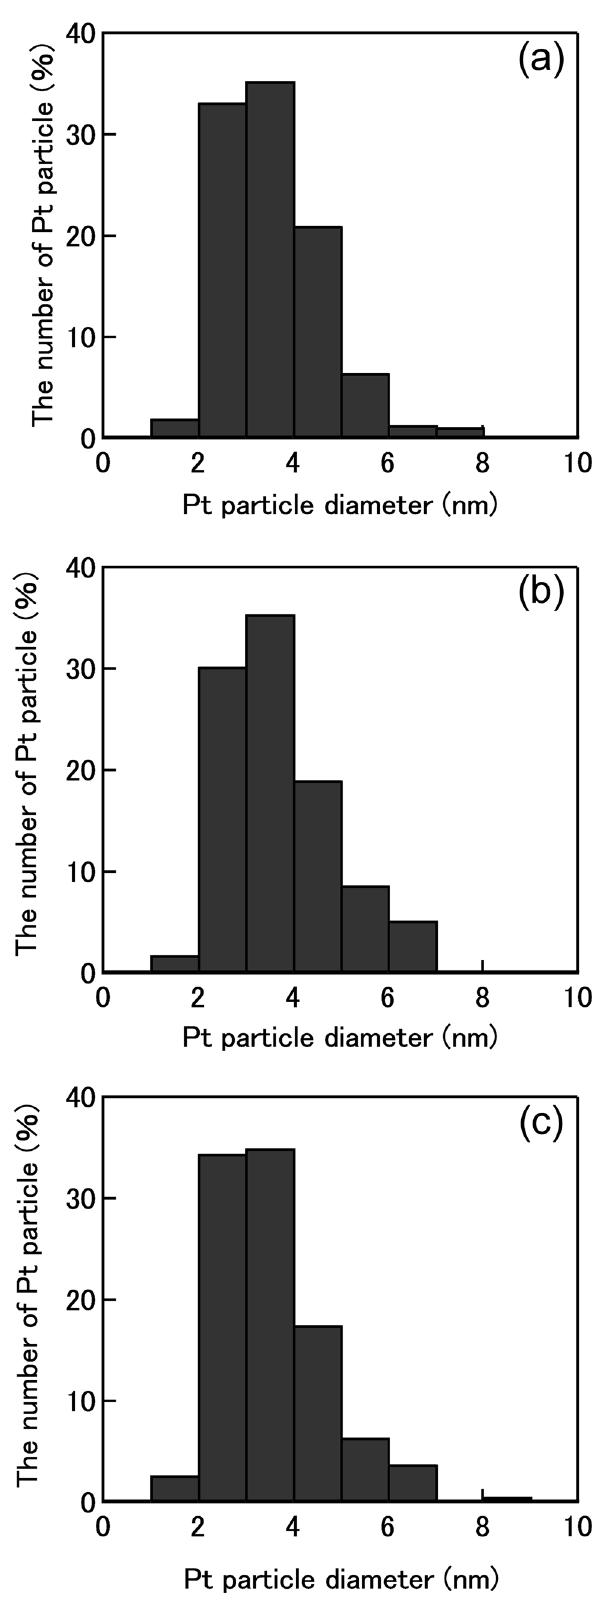
Fig. 5 A diameter distribution of the Pt particles supported on the MCs. a Pt(7.2 wt%)Ni100MC, b Pt(6.9 wt%)Ni80Cu20MC, and c Pt(14.8